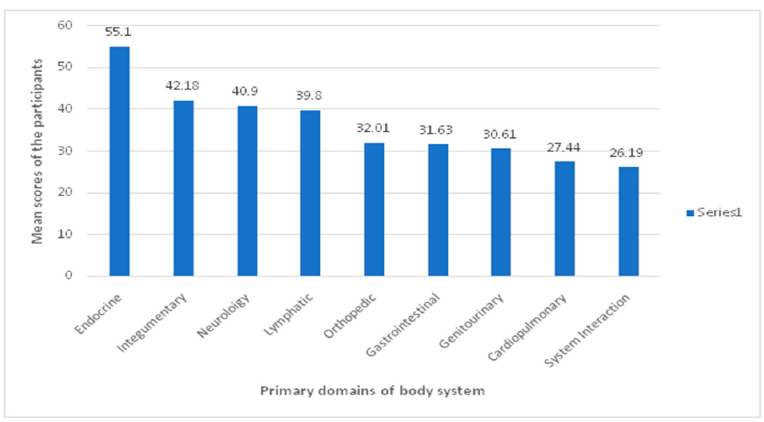
Figure 1. Mean knowledge score of participants in different domains of the body system.